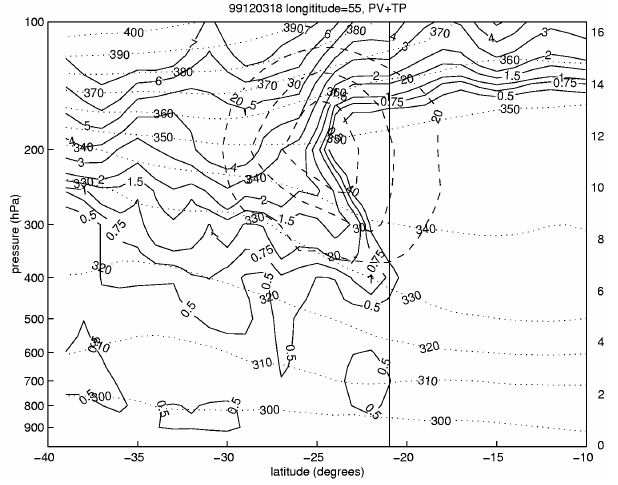
Fig. 7. Vertical longitudinal cross section of potential vorticity (in Figure 7 PVU, 1PVU = 10 − 6 m 2 .s 1 .kg − 1 , solid lines), potential temperature (in K, dashed lines) and horizontal wind (in m.s − 1 , dotted lines) on 3 December 1999 at the longitude 55 ◦ East. The latitude of Reunion Island (21 ◦ S) is marked by a vertical black line (from ECMWF data).